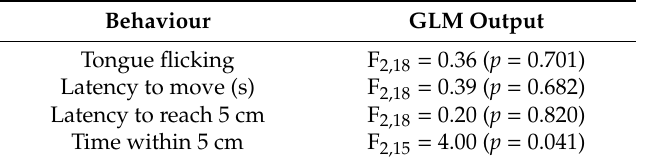
Table 2. Results of general linear model analysis to test the e ff ect of handling condition as a fixed factor on behaviour in the novel object test.